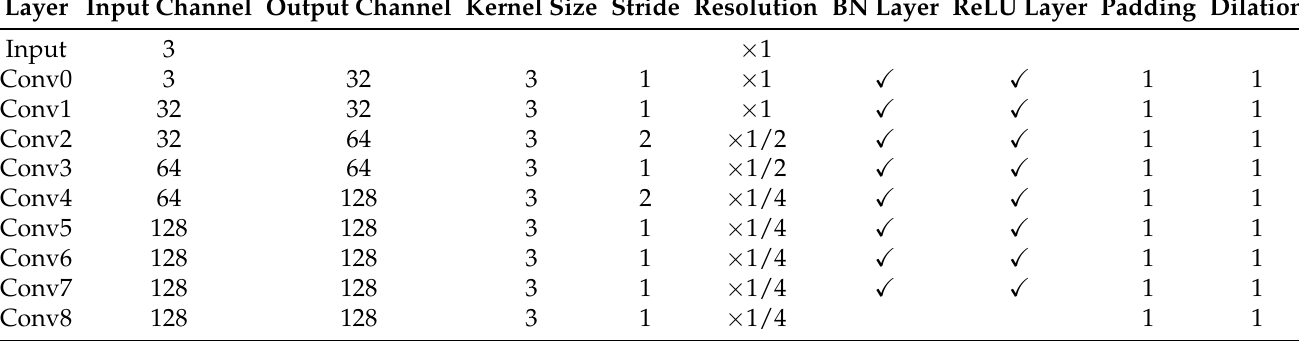
Table 1. Architecture parameter settings based on the L2-Net network. (Here (cid:88) means this layer is applied in the convolution